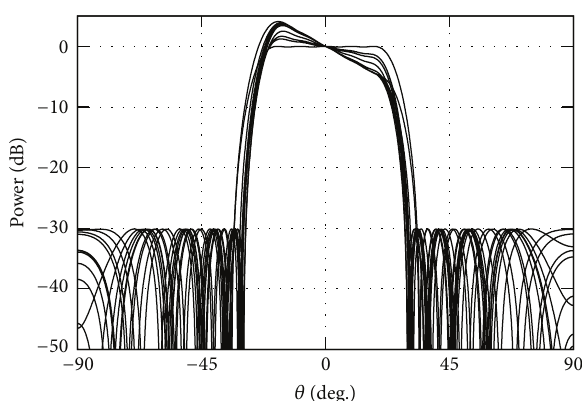
Figure 10: Collapsed 𝑆 𝑟𝑥 responses with their center normalized to 0 dB.